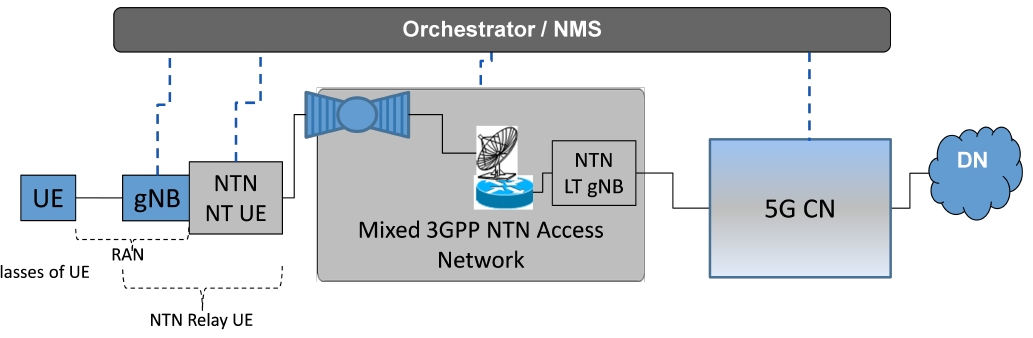
Figure 8. Scenario A3: indirect mixed 3GPP non-terrestrial access with bent-pipe payload [28].